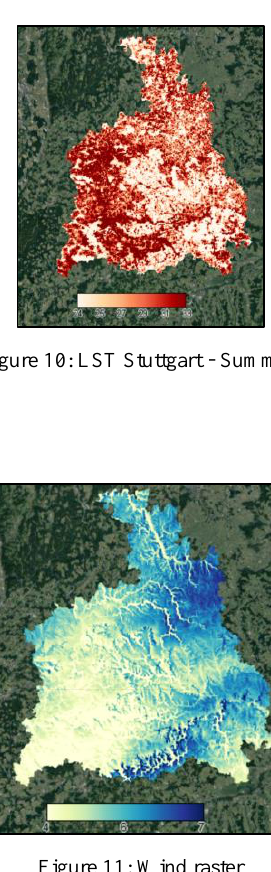
Figure 14: DEM Alos Palsar 30 m